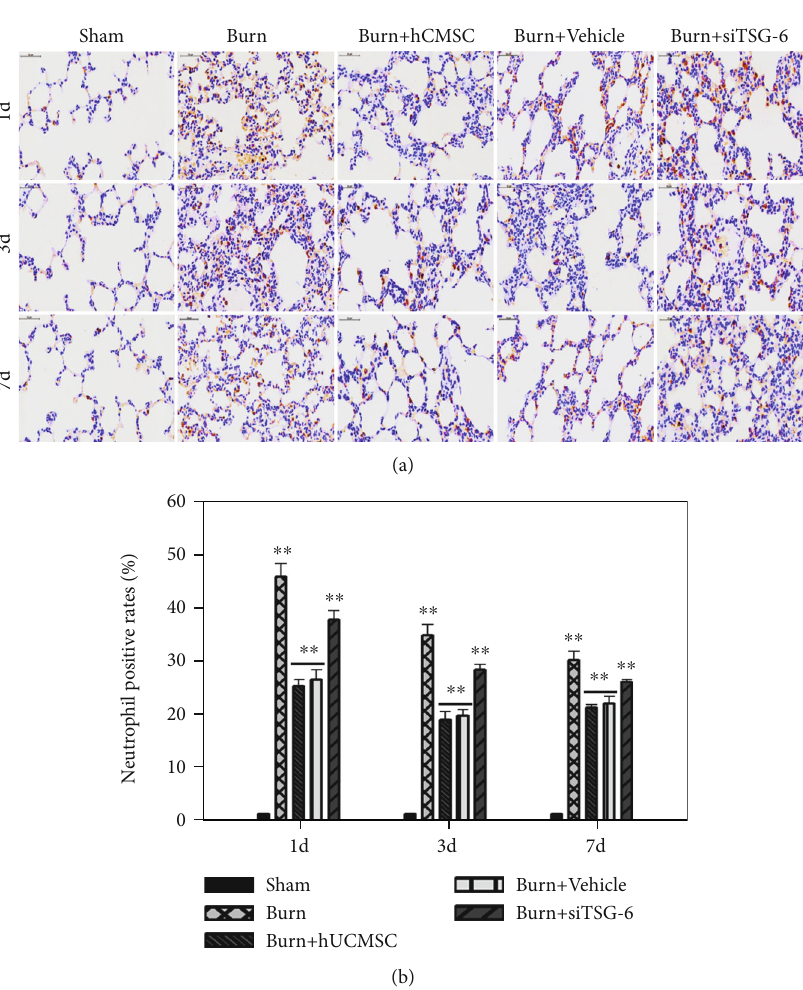
Figure 3: E ff ect of TSG-6 secretion and knockdown on neutrophil in fi ltrations of lung tissues induced by severe burn. (a) Representative photographs of MPO + in lung tissues using immumohistochemical staining are shown (the light microscope, 400x). (b) The quantitative analysis is shown in the corresponding histogram. Values are represented as mean ± SD ( n = 6 ). Asterisk ( ∗ ) and double asterisk ( ∗∗ ) stand for p < 0 : 05 and p < 0 : 01 ,